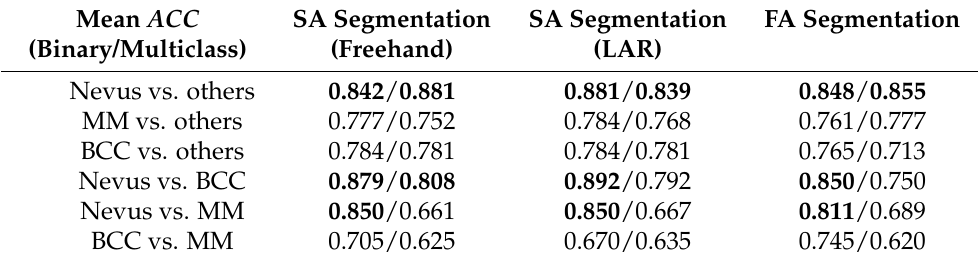
Table 4. Mean accuracy ( ACC ) values of binary/multiclass classification. Values over 80% are highlighted in bold